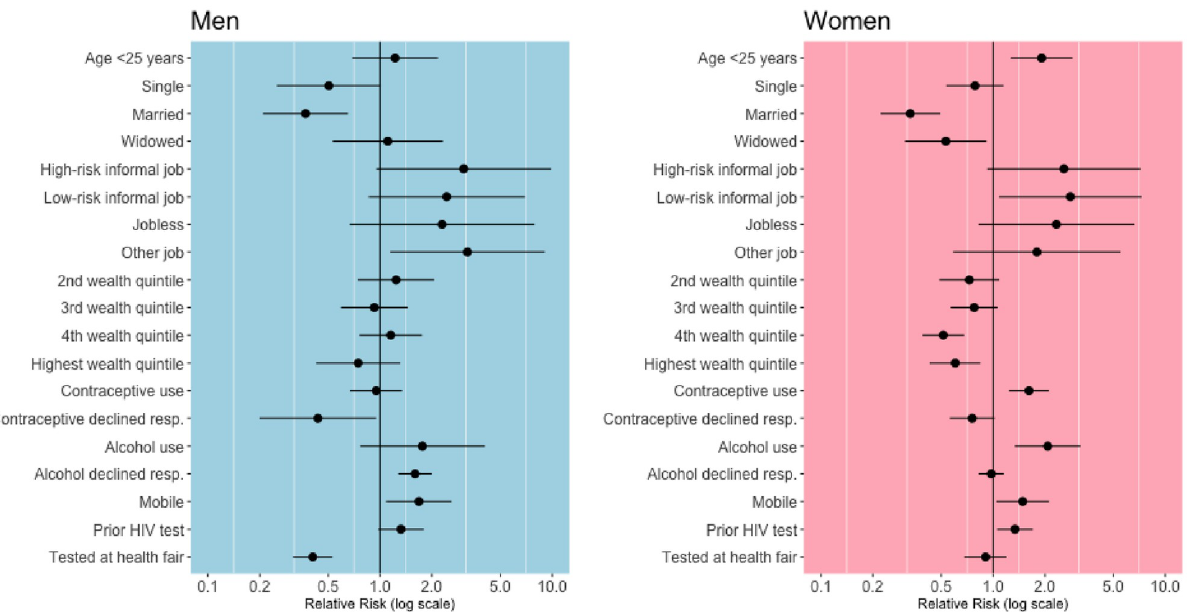
Fig 2. Adjusted risk ratios for HIV seroconversion stratified by gender. Analyses conducted among members of the HIV incidence cohort using targeted maximum likelihood estimation, controlling for incomplete follow-up and additionally adjusting for region and randomization arm � . � Reference categories were age 25+ years, separated or divorced, formal occupation, lowest wealth quintile, no contraceptive use, no alcohol use, non- mobile, no prior HIV test reported, and home-based testing.